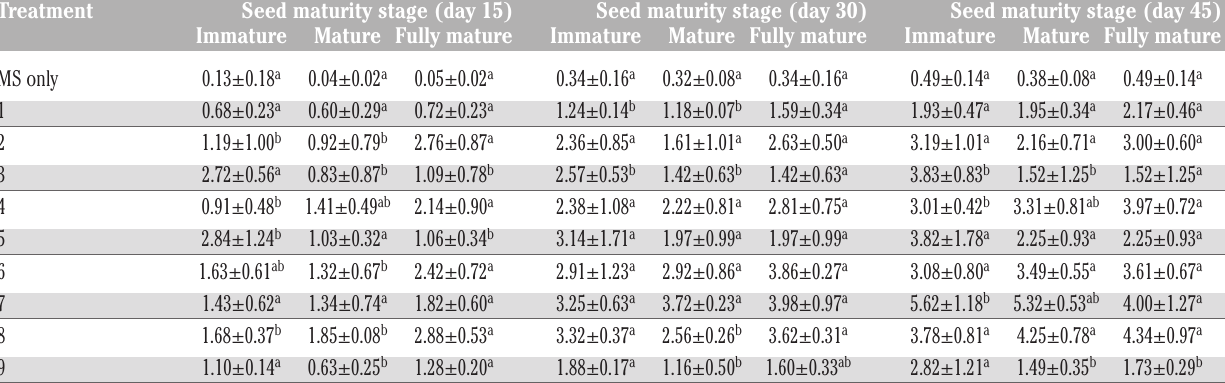
Table 3. Effect of different concentration of 2,4D and BAP on callus weight for seeds at different stages of maturity at the three time intervals.